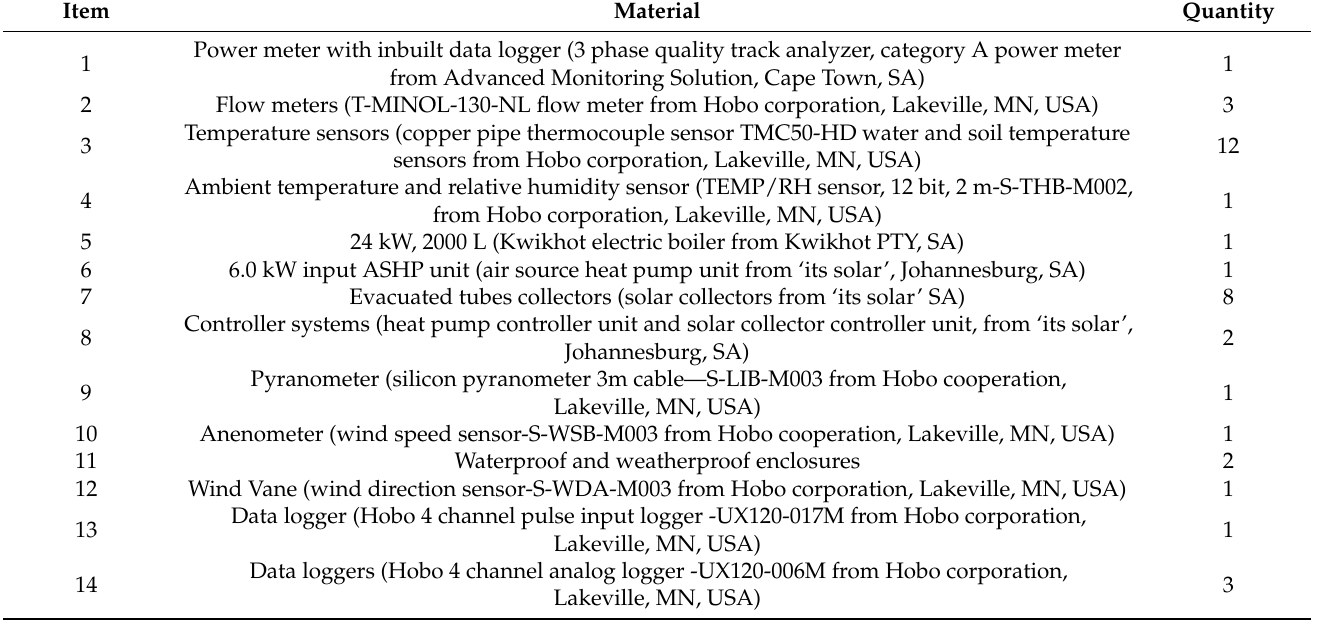
Table 1. Equipment, sensors, and data loggers used in the